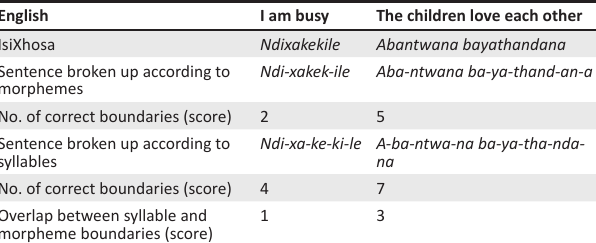
FIGURE 1: Example of a participant’s response on decomposition task – TABLE 2: Example of decomposition coding: ‘Ideal’ answer.